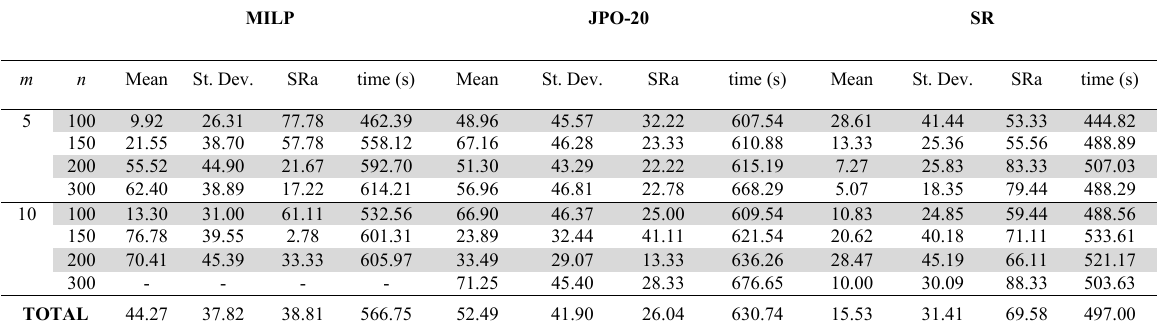
RDI and Success rate values for m and n